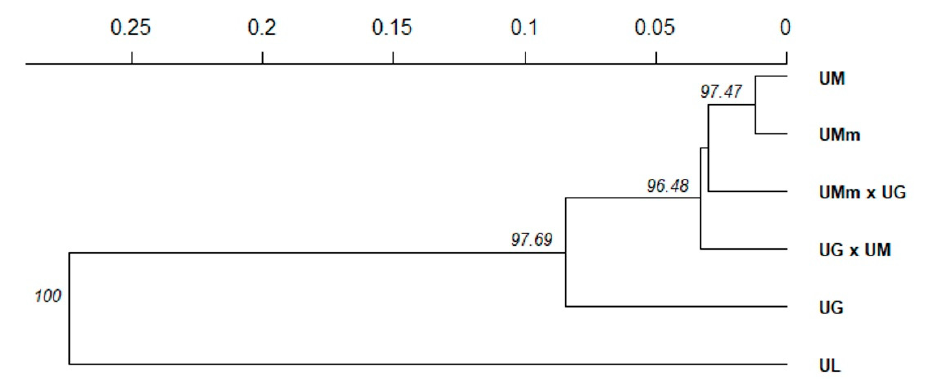
Figure 6. Results of UPGMA clustering based on Nei’s 1978 genetic distances [66]. The significance of branch nodes was tested with 10,000 bootstraps among loci (indicated by% of bootstraps separating a given branch).